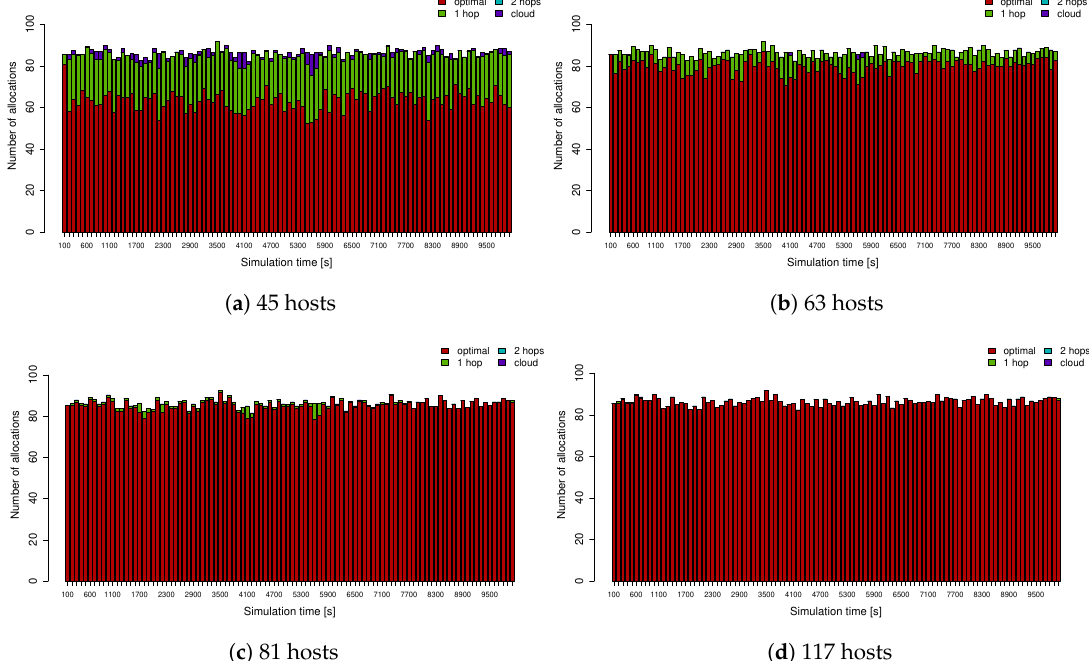
Figure 5. Number of allocations of edge services considering their distance to the MEC host that is providing the service. In Figure 6, we show the average number of migrations performed throughout the simulation time, considering 5, 7, 9, 11, or 13 MEC hosts per MEC datacentre and, thus, a pool of 45, 63, 81, or 117 hosts in the whole MEC system. The number of services run in the simulation is in the range of 8600 and 8700 (they vary depending on the simulation run); the maximum workload considered in this